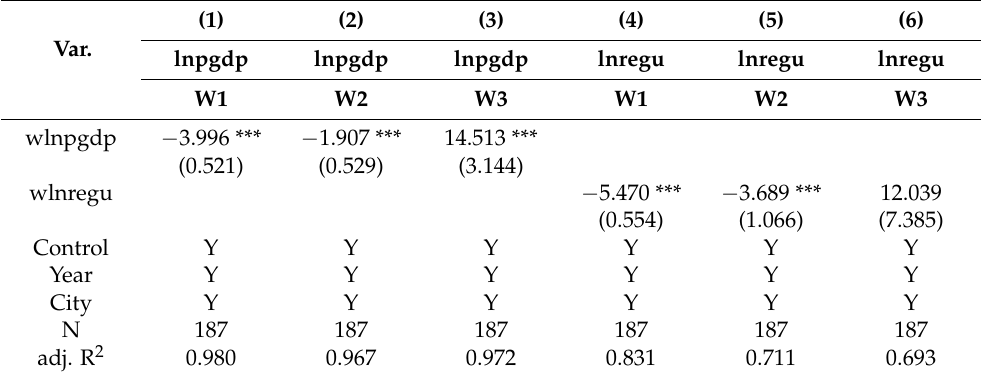
Table 2. The interaction of economic development and environmental regulation.